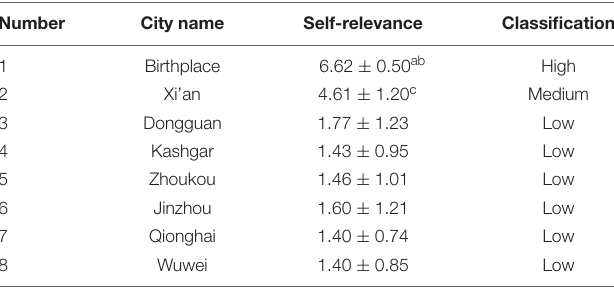
TABLE 1 | Assessment results of city self-relevance ( n = 35, X ±